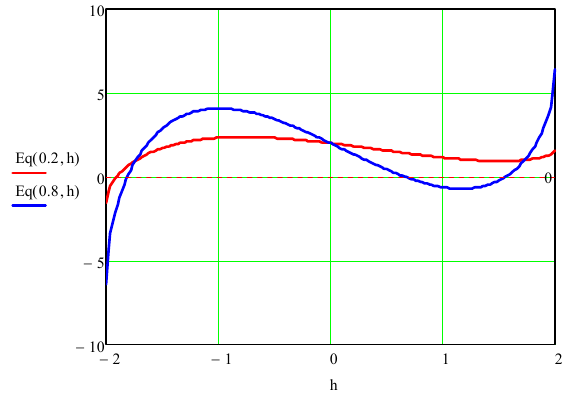
Figure 6. Graph of the left side of Equation (14).